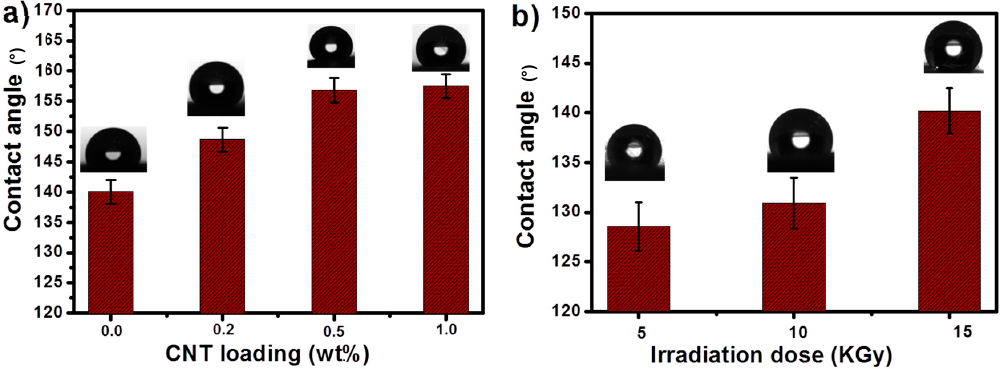
Figure 3. Contact angles for ( a ) pure PS and PS/CNT nanofibers, ( b ) for PS/0.5 wt.% CNT with different irradiation doses.